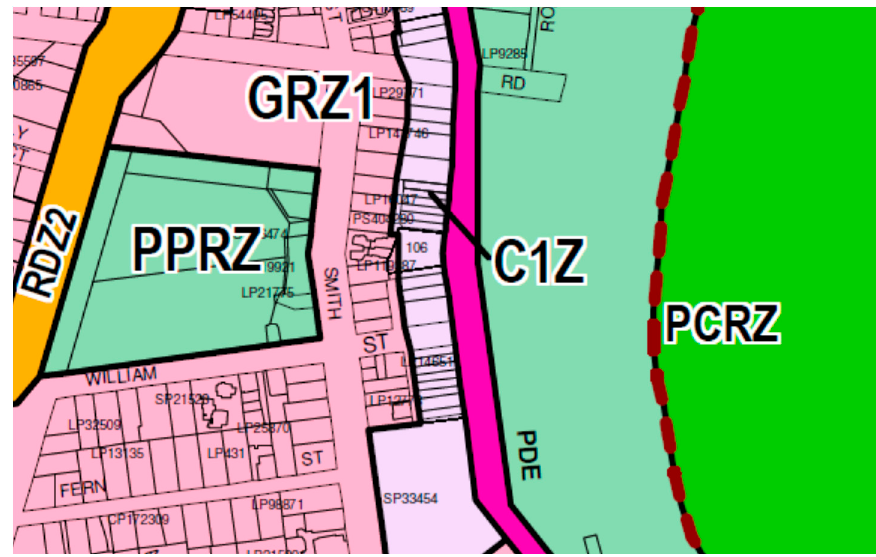
Figure 1. Extract of the Surf Coast Planning Scheme (Victoria, 2019: Map 43zn) for the subject land. Source: Surf Coast Planning Scheme (Victoria, 2019 vers.) [2]. Commons licence.